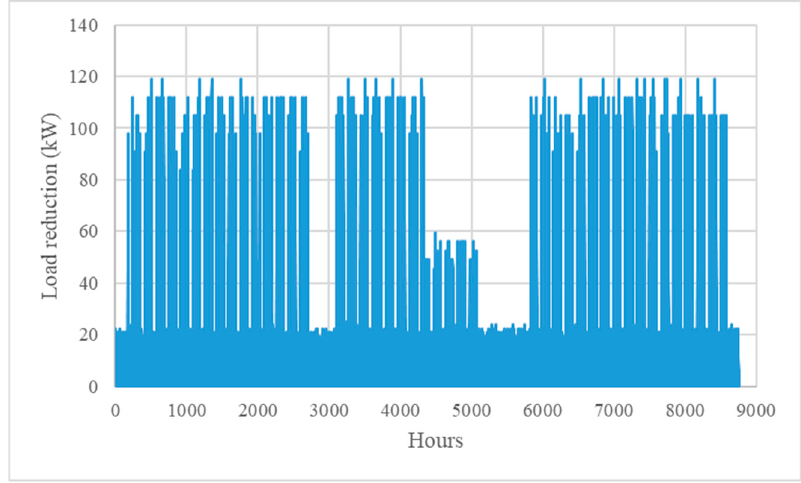
Figure 10. Annual variation of the additional load in the HMU campus after the installation of EV chargers.